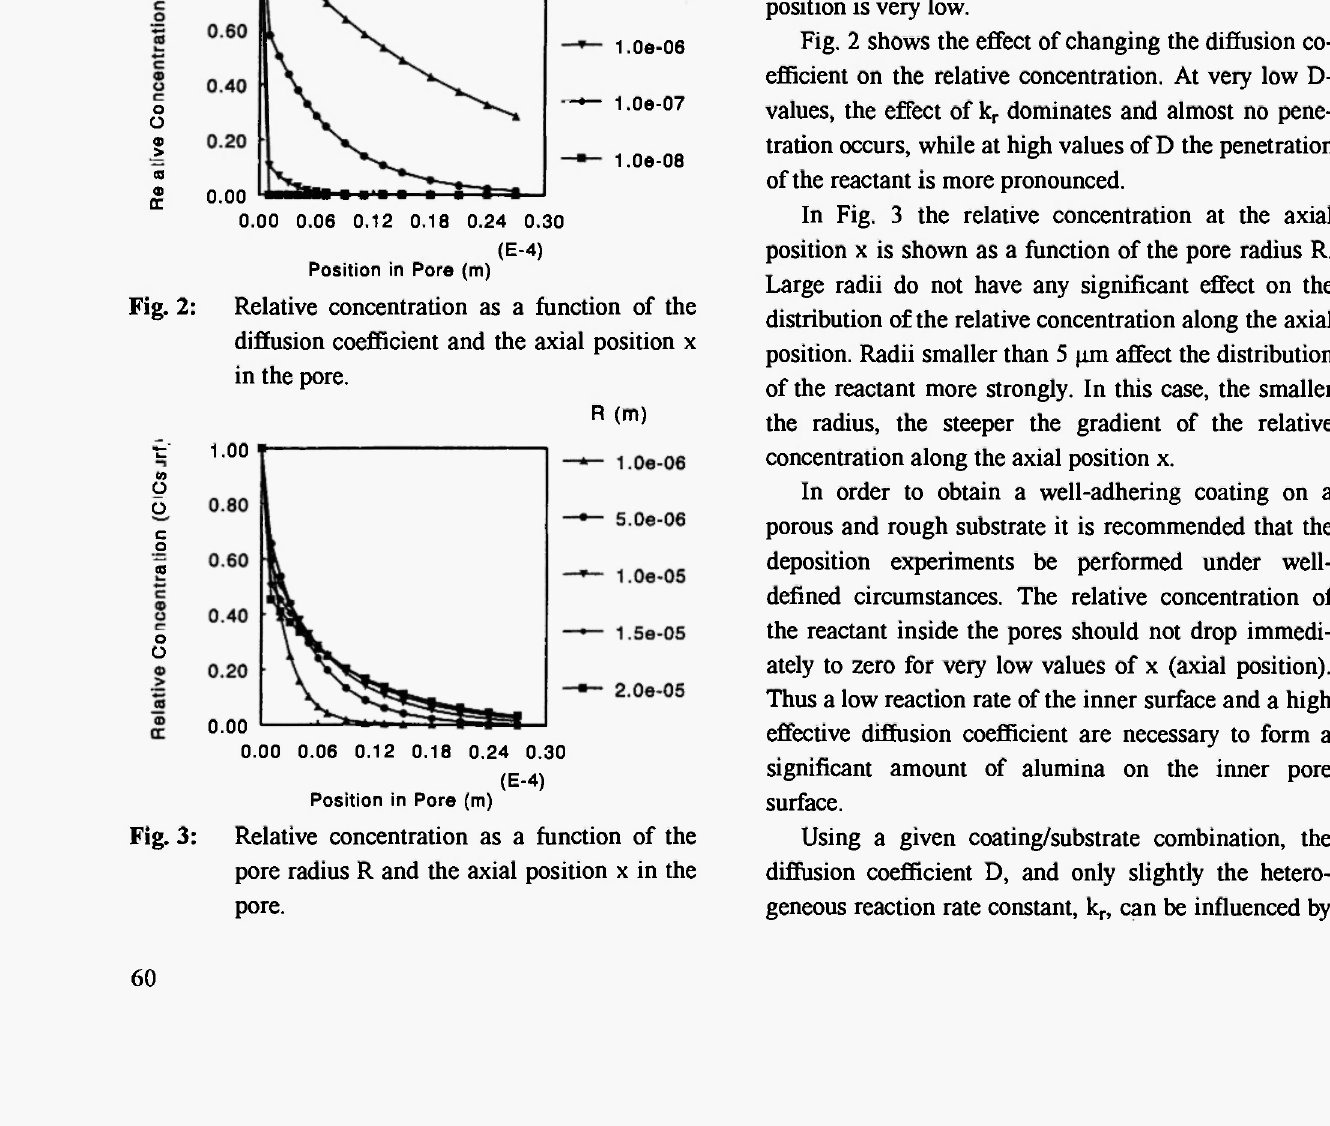
Fig. 2: Relative concentration as a function of the diffusion coefficient and the axial position χ in the pore.